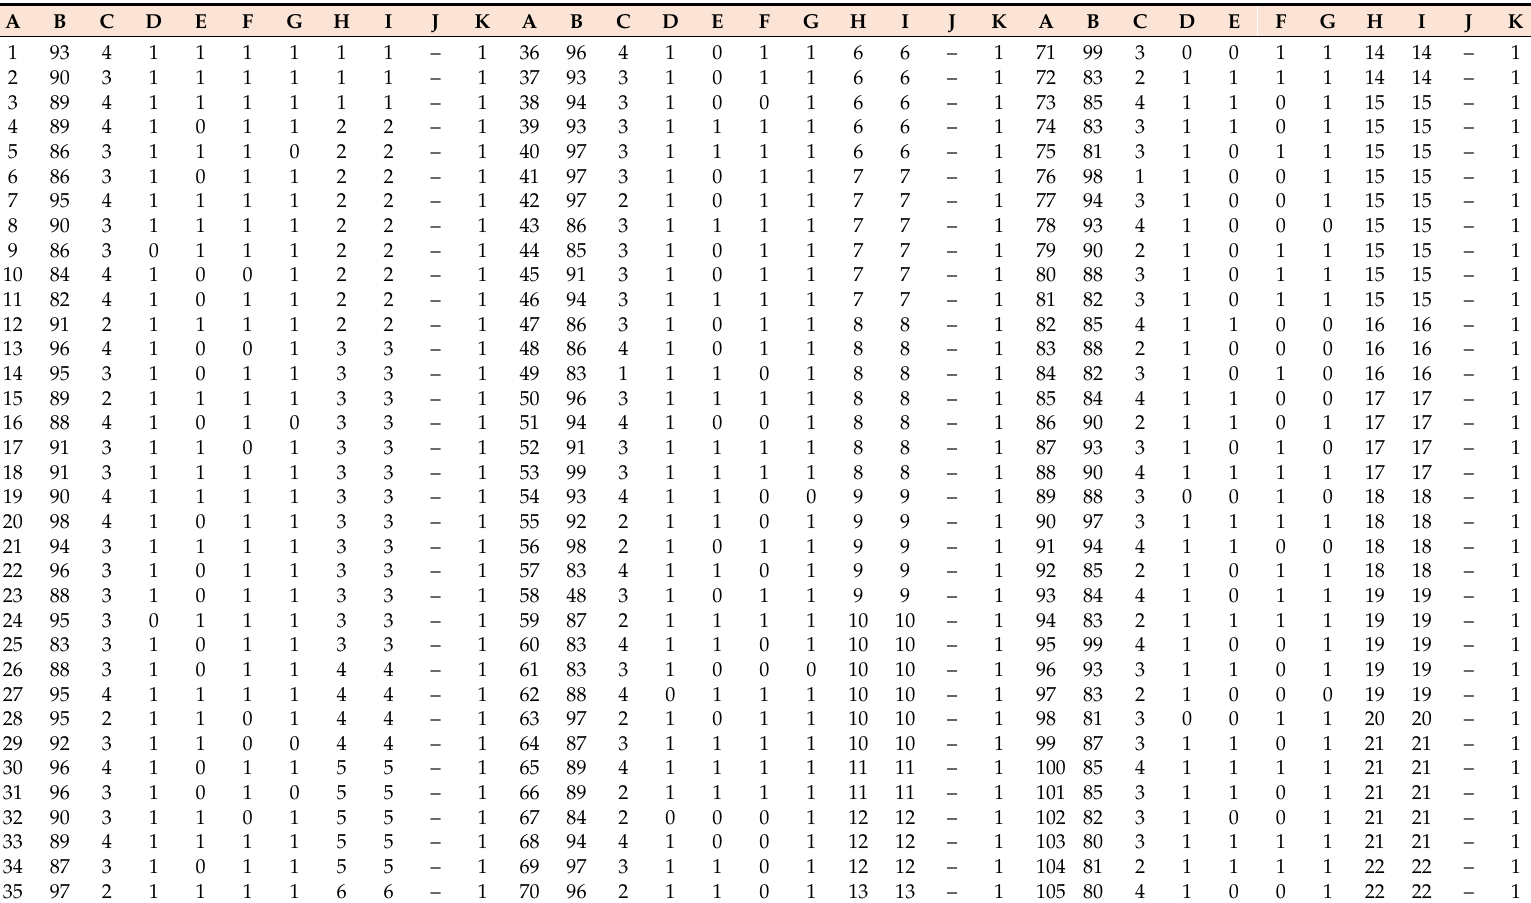
Table A1. Example Cancer Dataset ( N = 250). A = Observation number, B = Age, C = Grade, D = Lymph node invasion, E = Positive margin, F = No hormonal